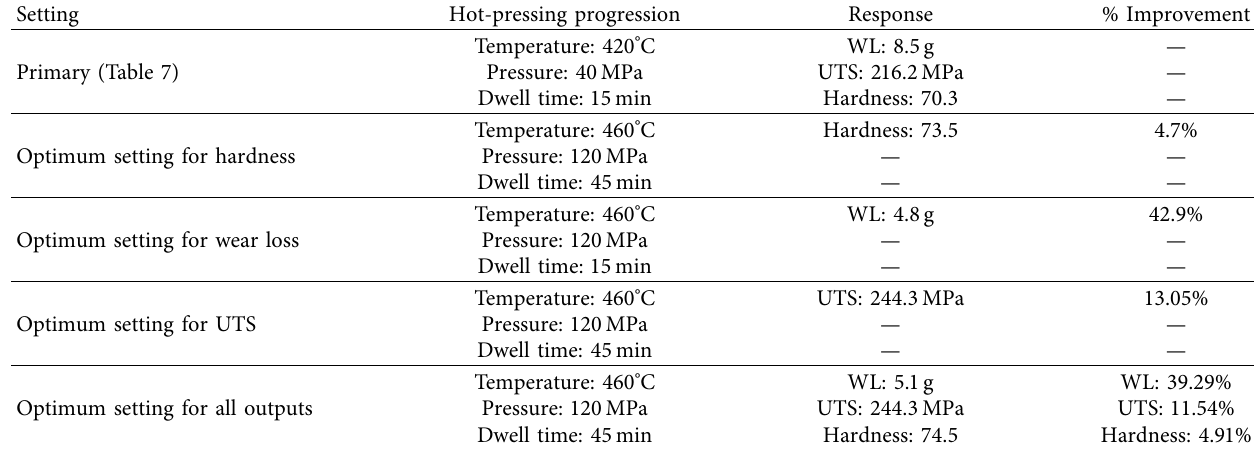
Table 11: Validation experimental outcome for optimum settings of hot-pressing progression.